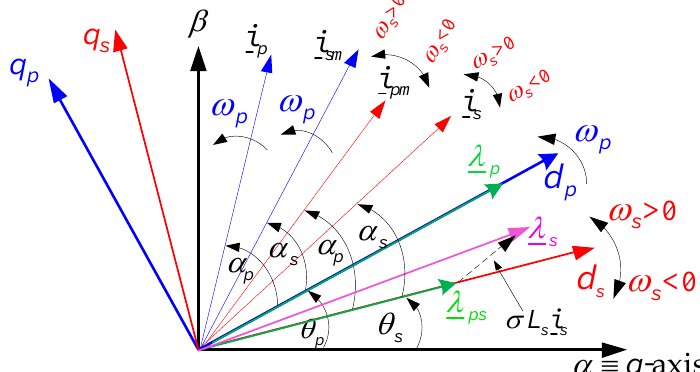
Figure 2. Phasor diagram and flux-oriented reference frames used in the BDFRM equations.